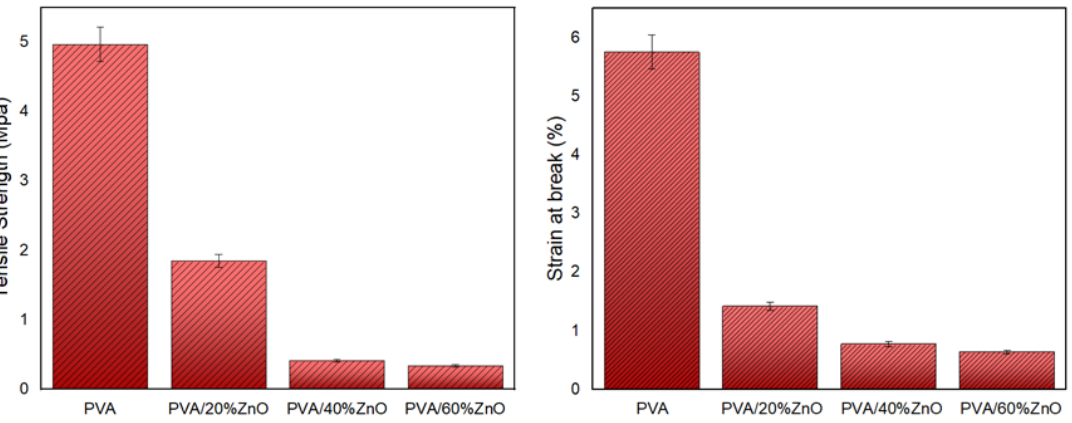
Figure 4. Mechanical parameters of all fibers: the tensile strength (Mpa) and strain break (%).